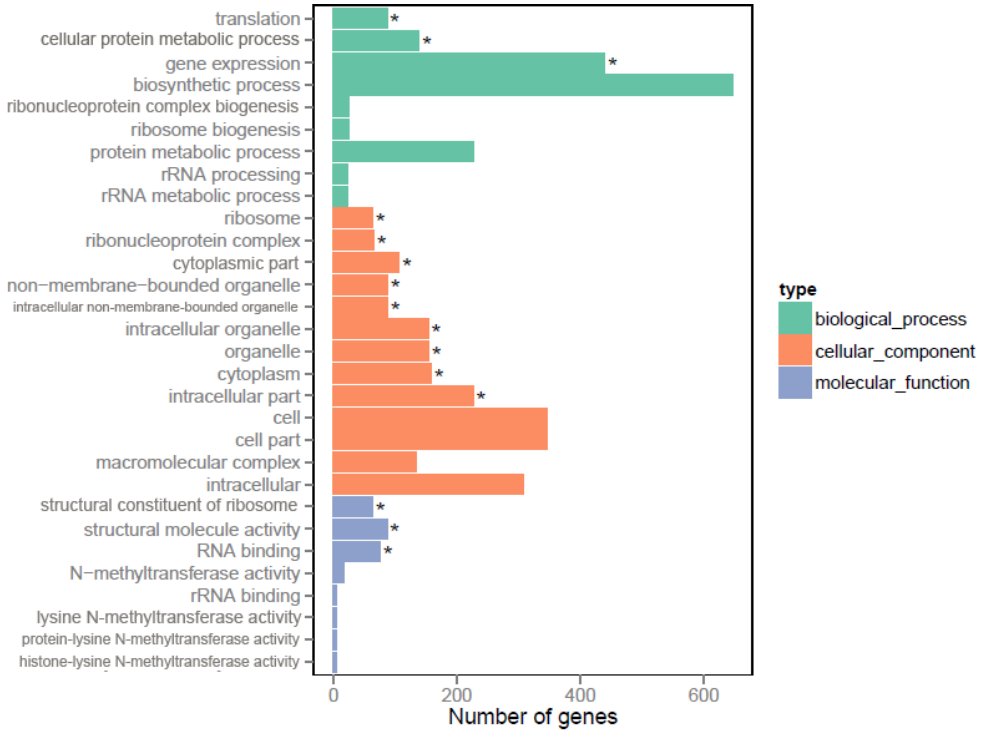
Figure 3. Functional categorization of DEGs in gene ontology (GO) in strain ST042. The asterisks indicate significantly enriched GO terms.